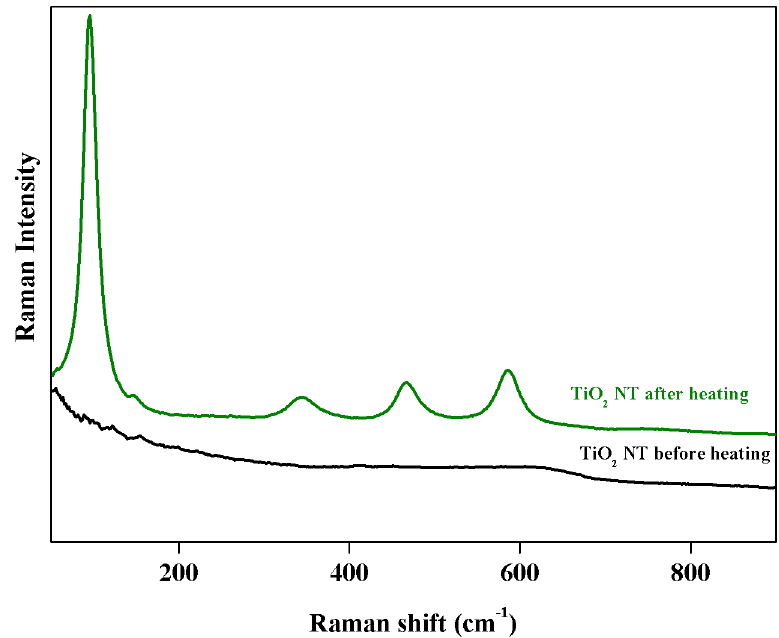
Figure 11. Raman spectra for TiO 2 NT before (black) and after (green) heat treatment at 450 °C in air (2 h).